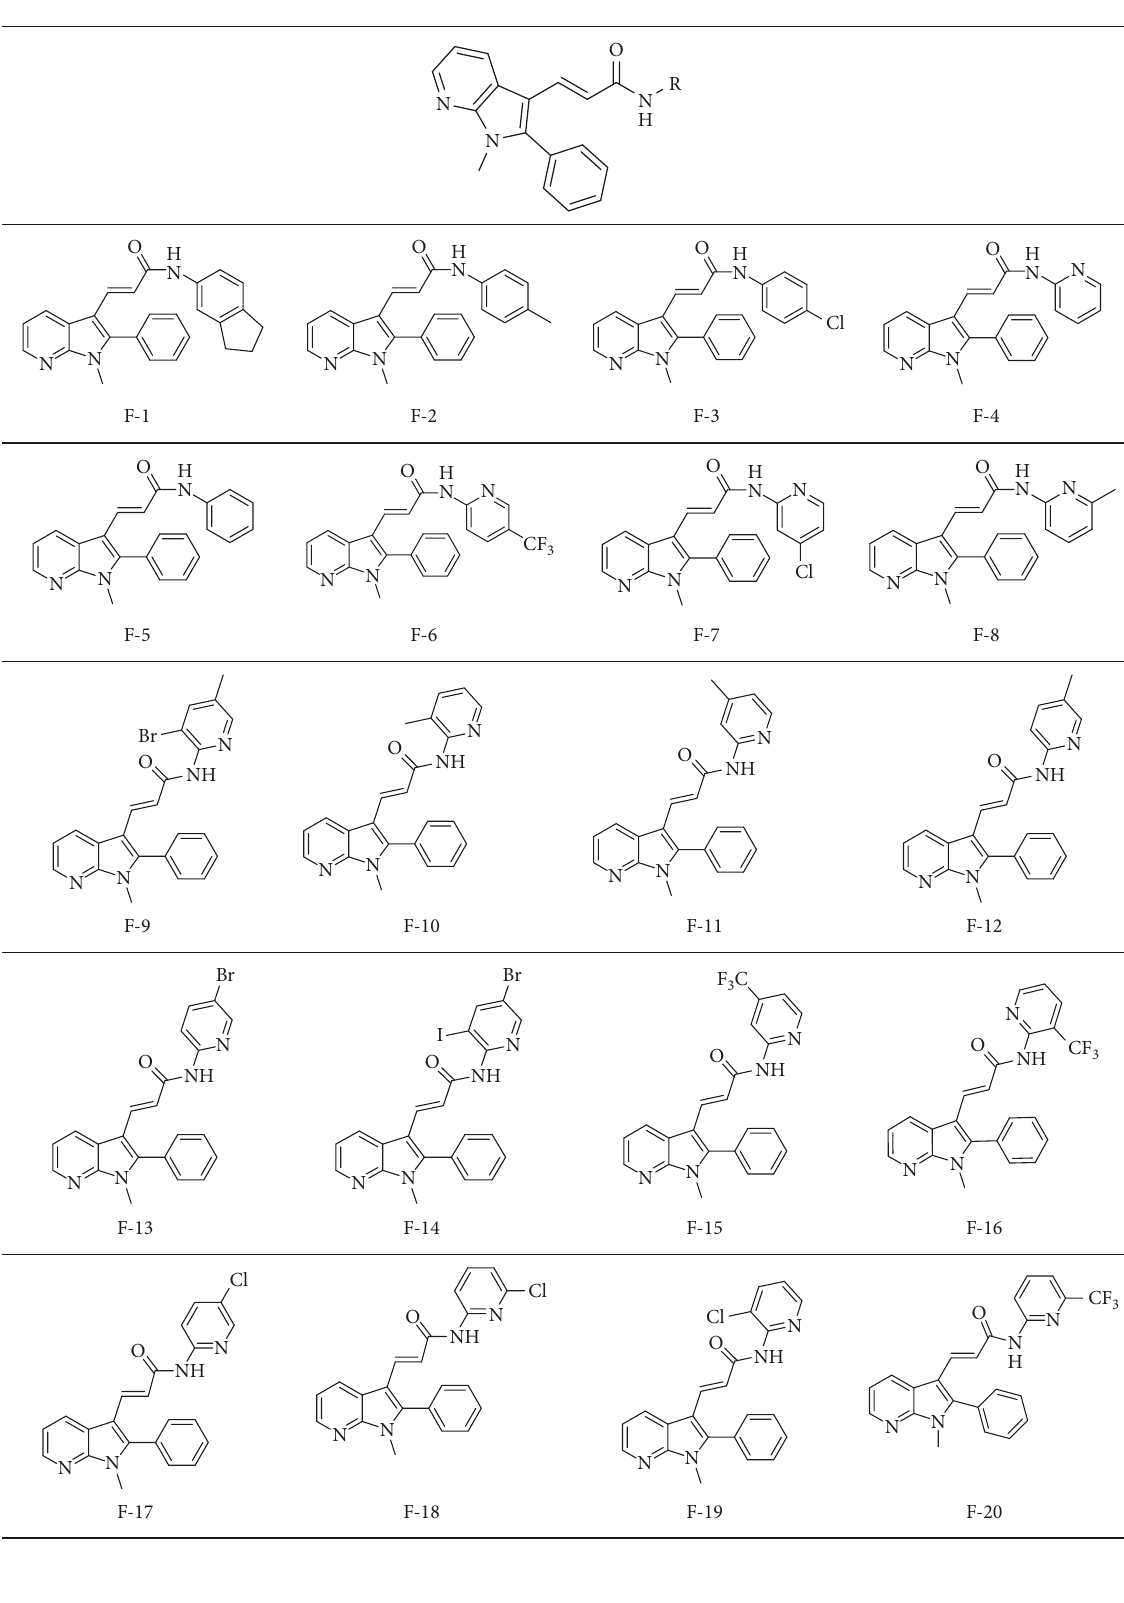
Table 1: SAR for novel SIS3